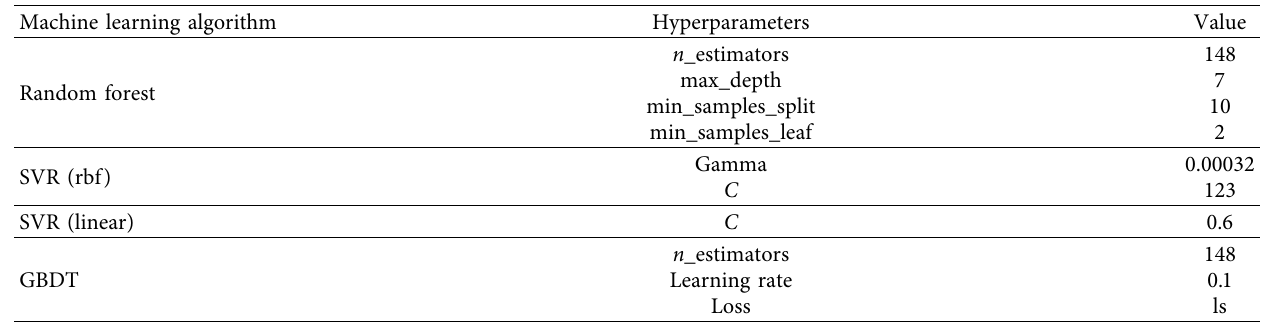
Table 6: Hyperparameters in machine learning.